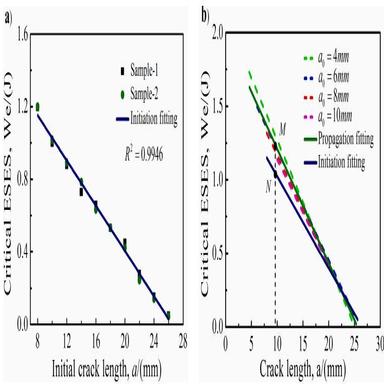
(a) The fitting line between the critical elastic strain energy storage We and various crack lengths a of the U-notches with different initial lengths a0 during the crack initiation. (b) The comparison among different fitting lines of the U-notches with different crack lengths a0 during the crack initiation and propagation.